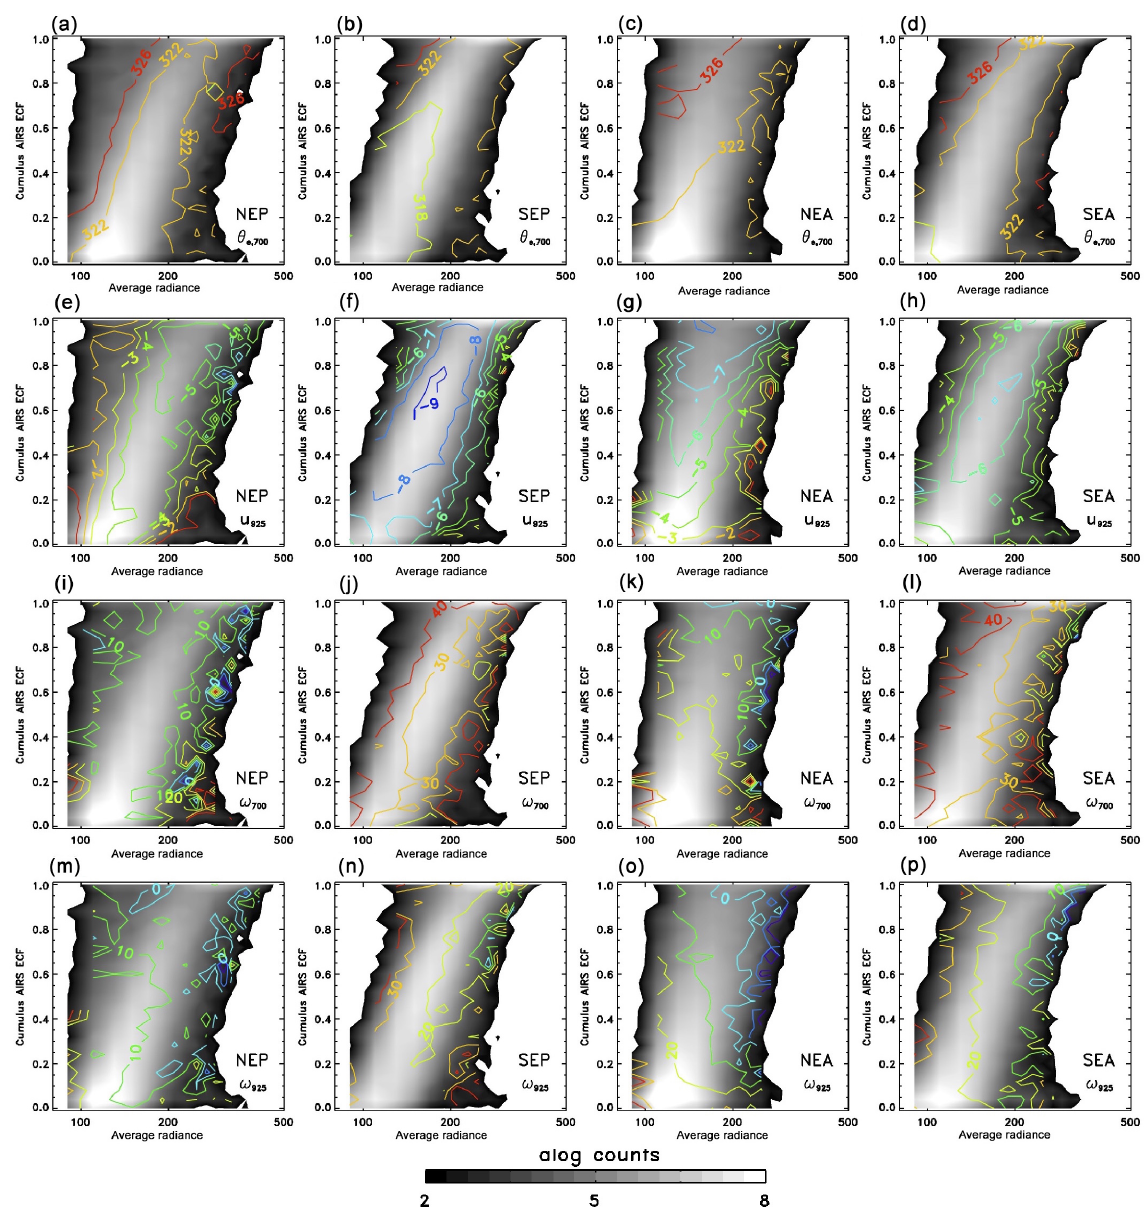
Figure 12. Joint PDFs of 700hPa θ e , u 925 , ω 700 , and ω 925 for the four regions listed in Table 1.